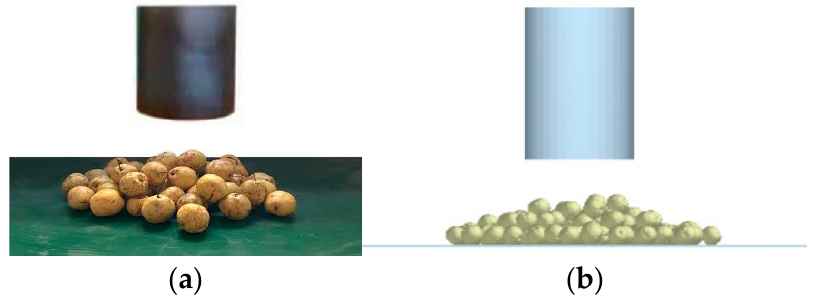
Figure 9. Experiment of simulation parameters verification. Physical experiment ( a ); Simulation experiment ( b ).